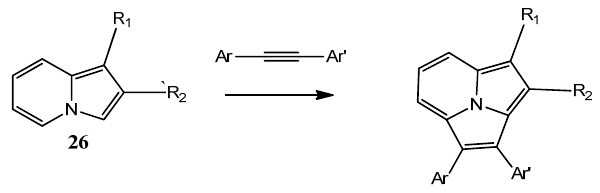
tion. Novel reaction conditions were found for cycloaddition reaction, so that the role of oxidant was played by O 2 in presence of Pd(OAc) 2 [47], Scheme 10. Many 1-alkoxycarbonyl derivatives ( 26a – l ) were involved in the reaction with acetylenes of the type ArC ≡ CAr, Table 3.